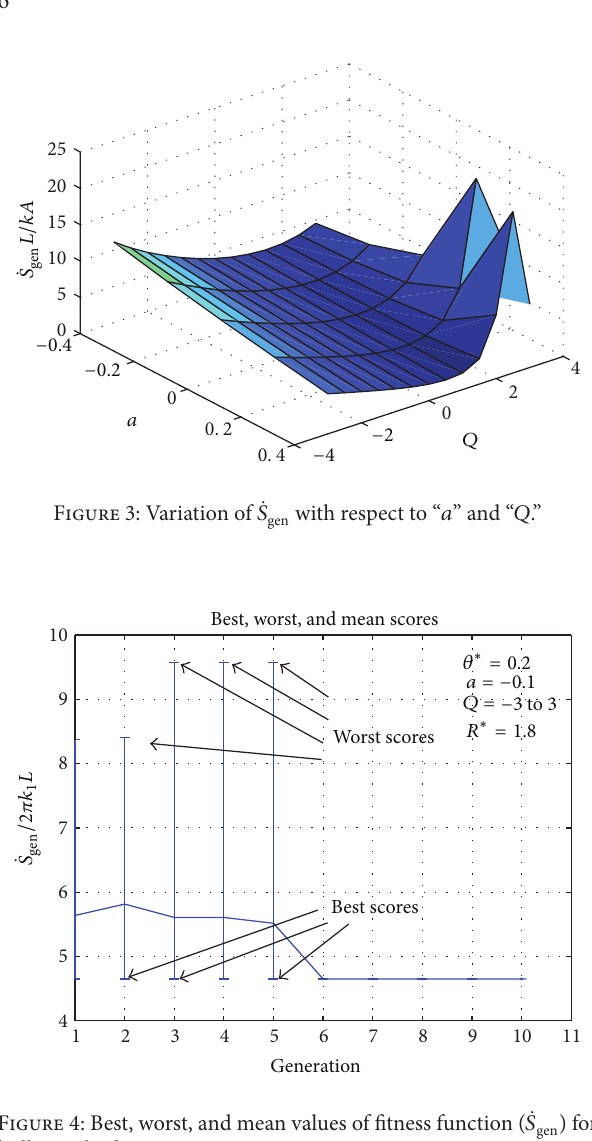
Figure 4: Best, worst, and mean values of fitness function ( hollow cylinder.